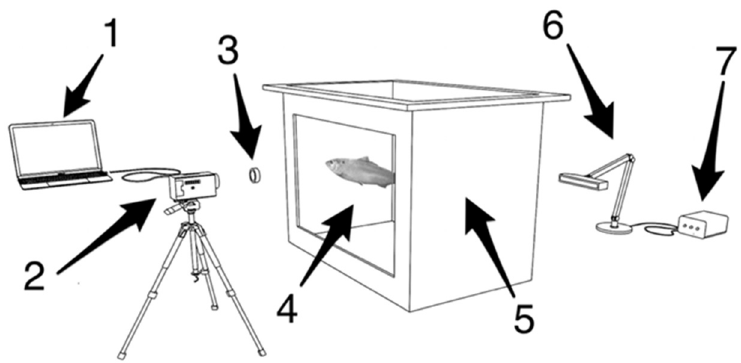
Figure 1. Arrangement of materials.